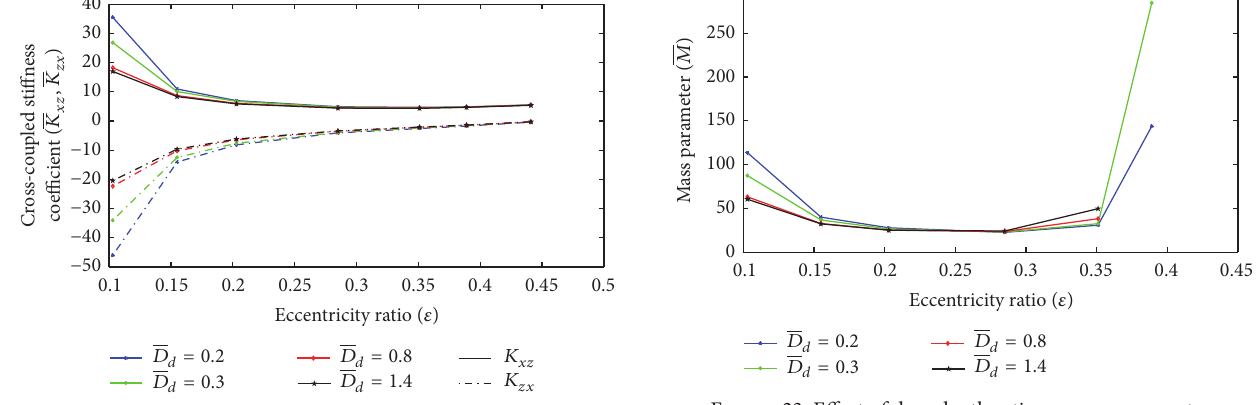
the reason that in case of 𝐷 𝑑 = 0.8 and 1.4 the bearing goes to the infinite stability zone after 𝜀 = 0.351 , whereas in case of 𝑅 𝑑 = 0.2 to 0.3 bearing attains the infinite stability after 𝜀 = 0.389